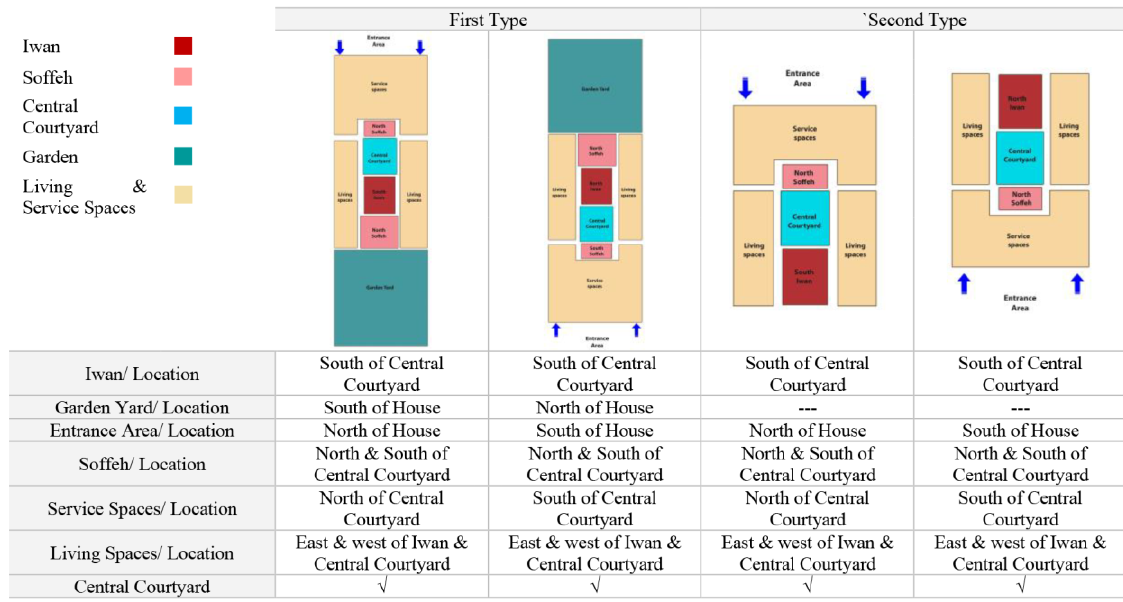
Table 6. Classification of typologies of Ardakan Muzaffarid Houses. Reference: